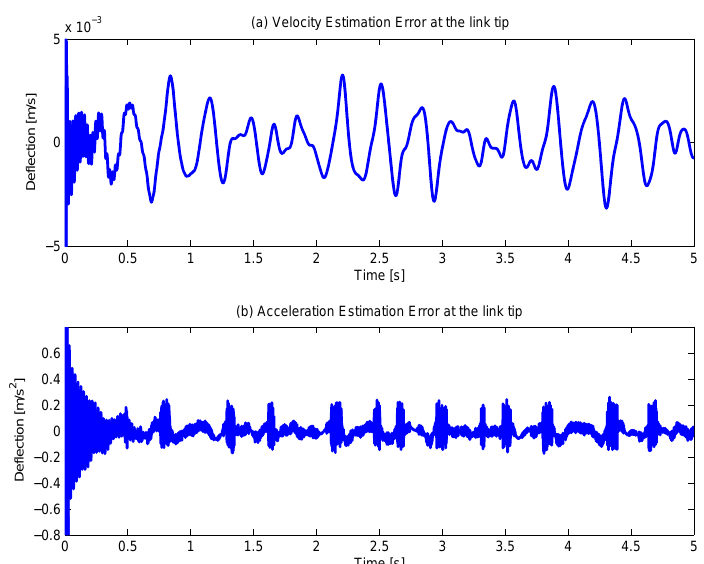
Figure 11. Virtual Sensor link deflection speed and acceleration error.